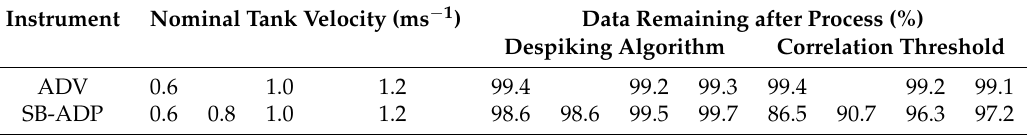
Table 5. Percentage of data remaining after data